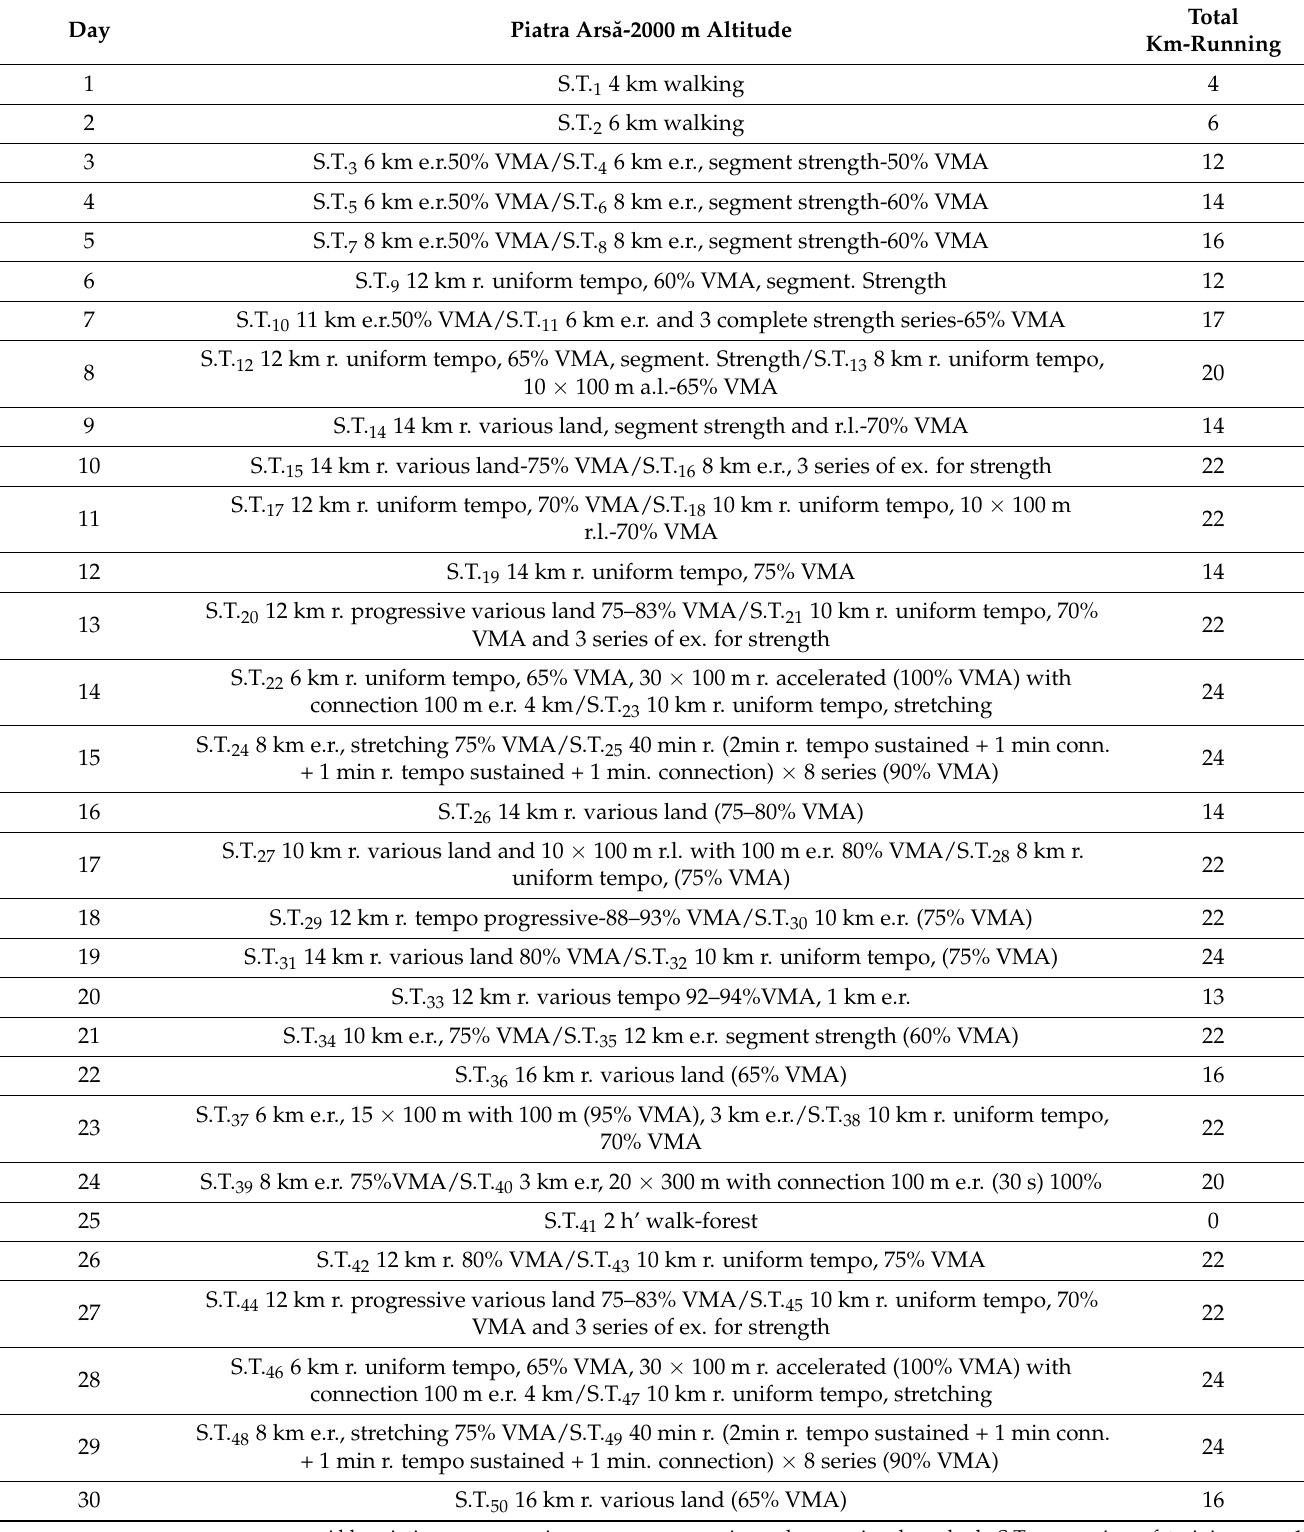
Table 1. Example of a training